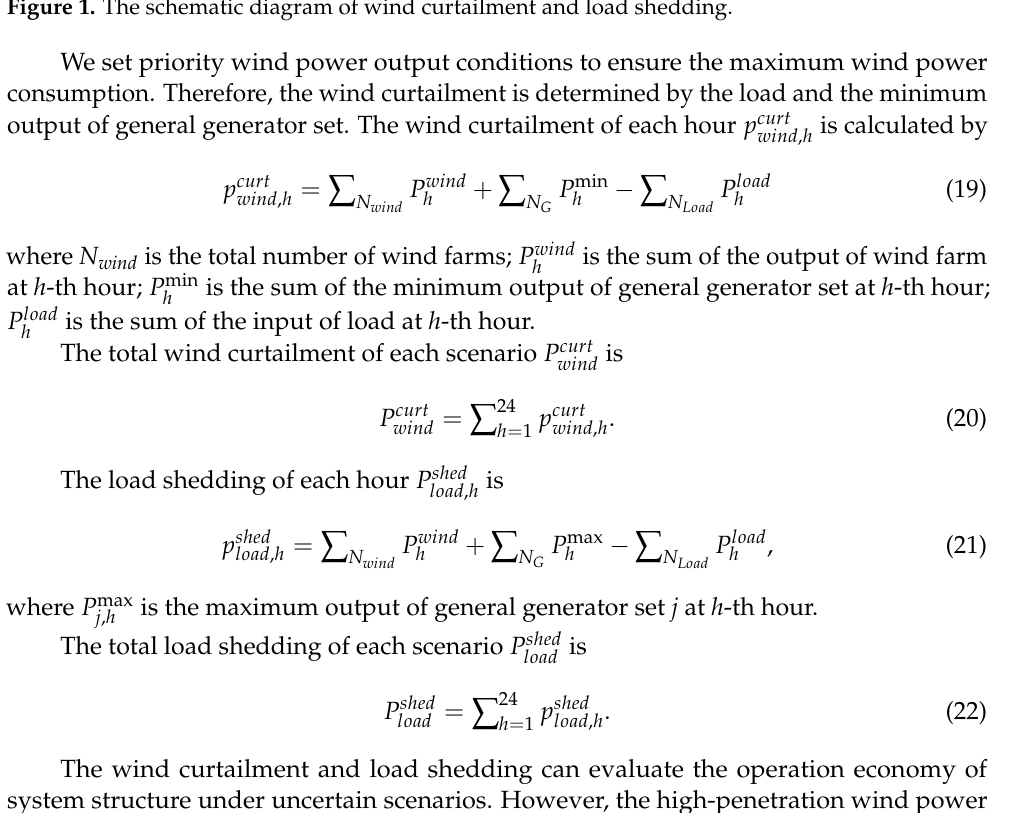
Figure 1. The schematic diagram of wind curtailment and load shedding.